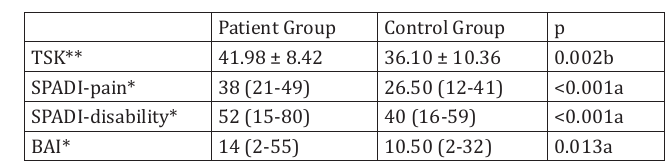
Comparison of kinesiophobia, pain, disability and anxiety scores between patient and control groups